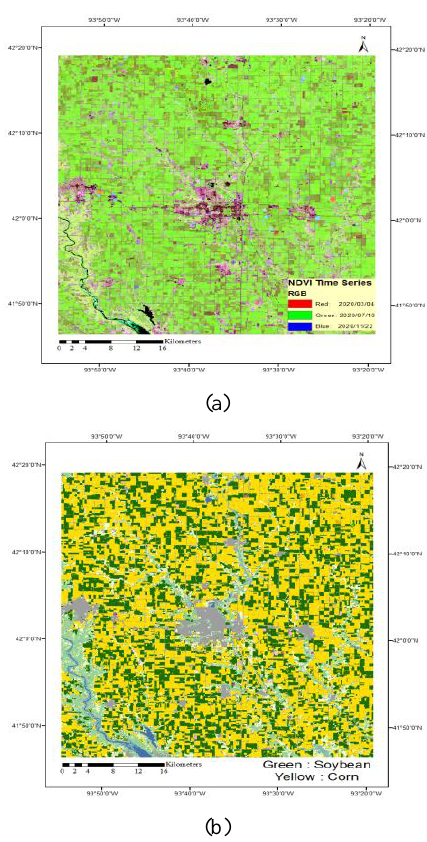
Figure 3. NDVI index (a) and ground truth map (b).